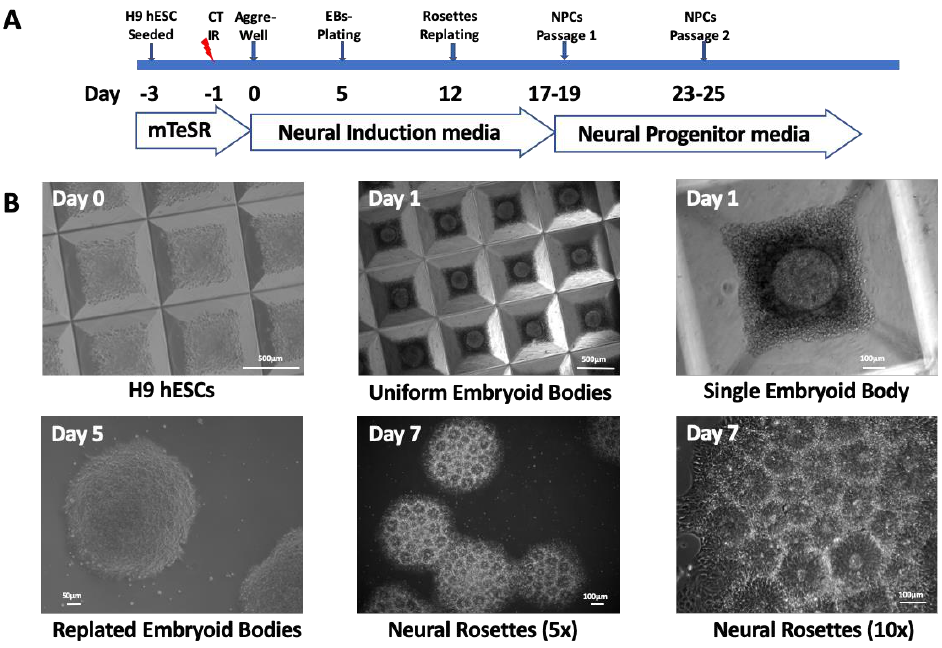
Figure 1. ( A ) Timeline of radiation exposure and subsequent cell culture passaging. ( B ) Development of neural morphologies as human embryonic stem cells (hESCs) progress to embryoid bodies and then neural rosettes.